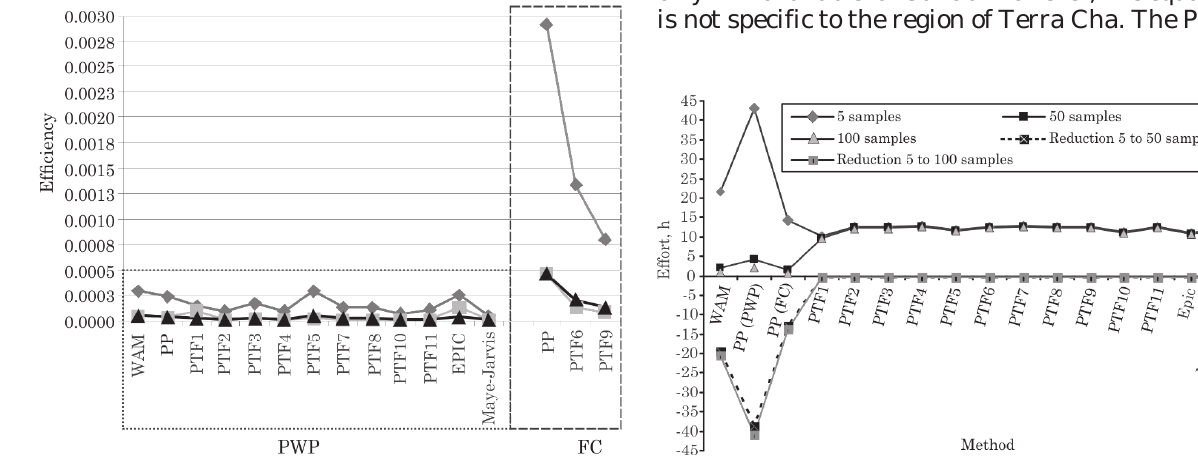
Figure 3. Efficiency of different methods determining and estimating hydro-physical properties in terms of effort and cost.